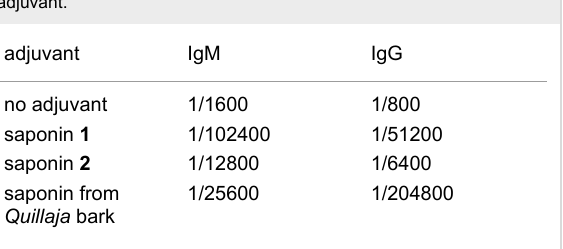
Table 6: Serum titer data for antisera against 3’SL-polyacrylamide cover antigen obtained by immunization with 3’SL-KLH neoglycoconju- gate with adjuvants 1 , 2 , and saponin from Quillaja bark, or without an adjuvant.